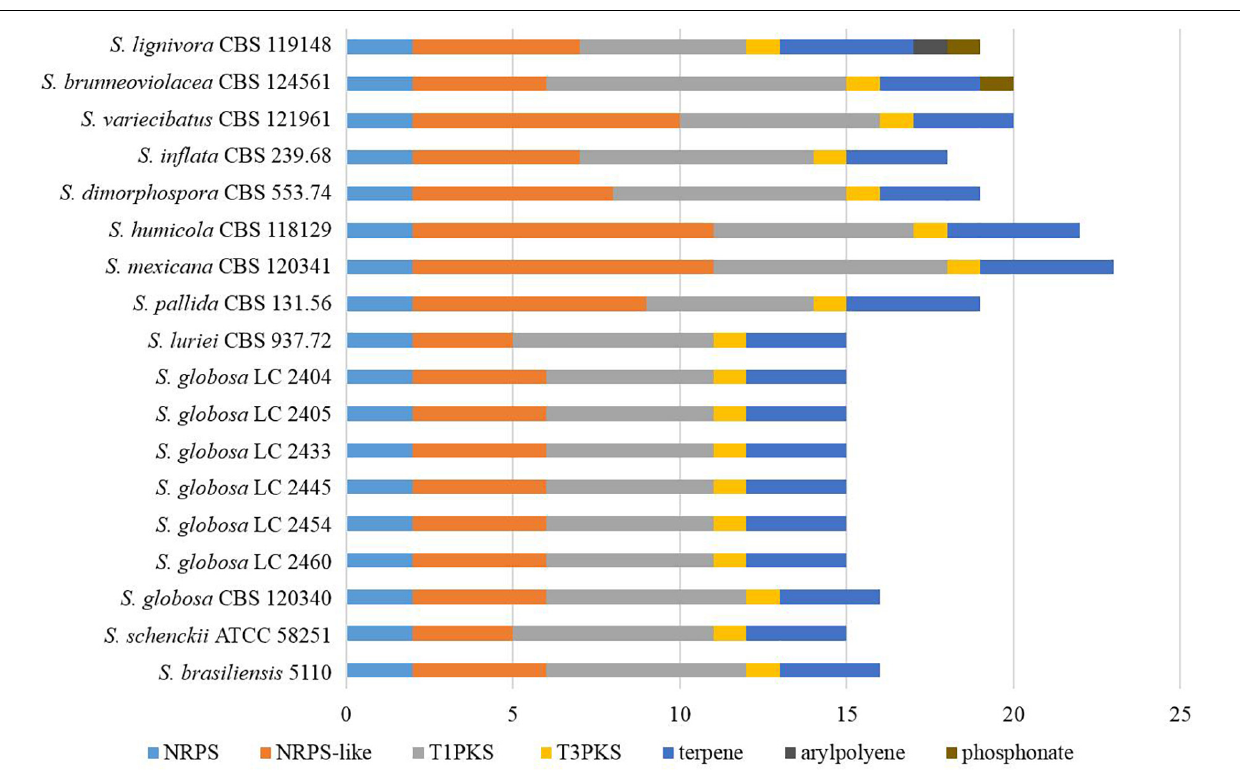
FIGURE 10 | The putative secondary biosynthetic gene clusters identified in the genomes of Sporothrix species. Secondary biosynthetic gene clusters of Sporothrix were identified though antiSMASH platform. These putative gene clusters belonged to tIpks , nrps, terpene, tIIIpks , indole, arylpolyene, and phosphonate. Gene clusters of tIpks and nrps were less in the four main clinical species ( S. brasiliensis , S. schenckii , S. globosa, and S. luriei ) than those of the environmental and other clinical